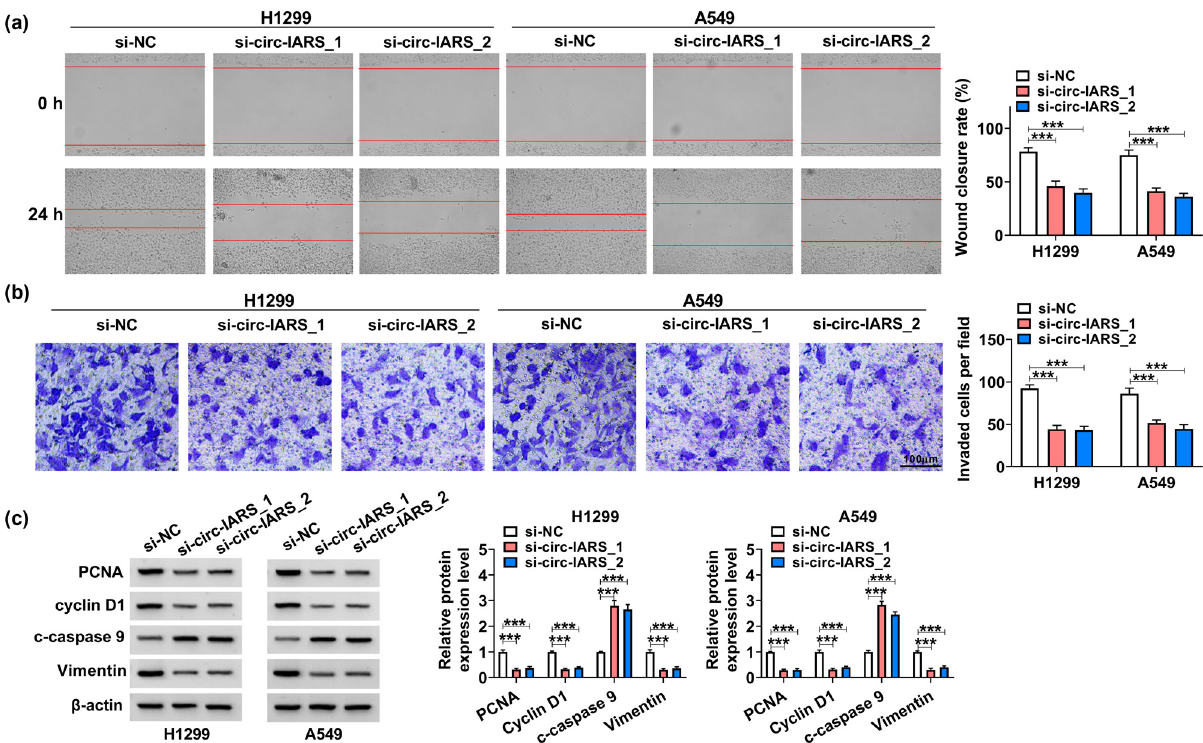
Figure 2: Exhausting circ - IARS could antagonize cell migration and invasion of NSCLC cells. ( a ) Scratch wound assay measured wound closure rate in H1299 and A549 cells after transfection. ( b ) Transwell assay examined the invaded cells per fi eld ( 100 ×) after transfection. ( c ) Western blotting detected the relative protein expression levels of PCNA, cyclin D1, c - caspase 9, and vimentin in transfected cells, normalized to β - actin. *** P <